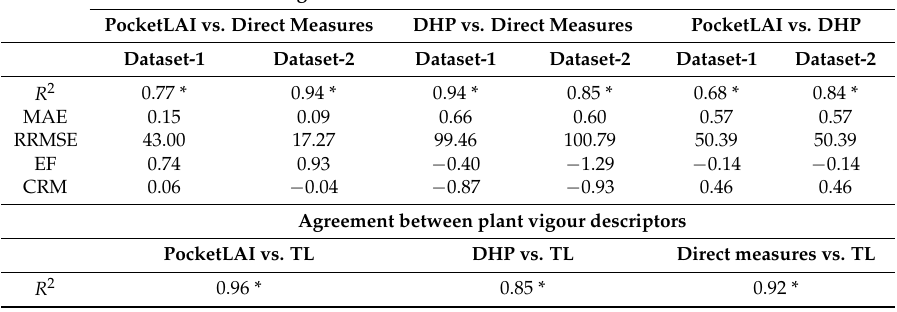
Table 2. Agreement between LAIv estimated with PocketLAI, hemispherical photography (DHP), and direct measurements, considering the whole dataset (Dataset-1) and excluding the outlying value of a very high-vigor sampling area (Dataset-2), and agreement between LAIv measured with different methods and the theoretical number of leaves (TL). Legend: MAE: mean absolute error; RRMSE: relative root mean square error; EF: modelling efficiency; CRM: coefficient of residual